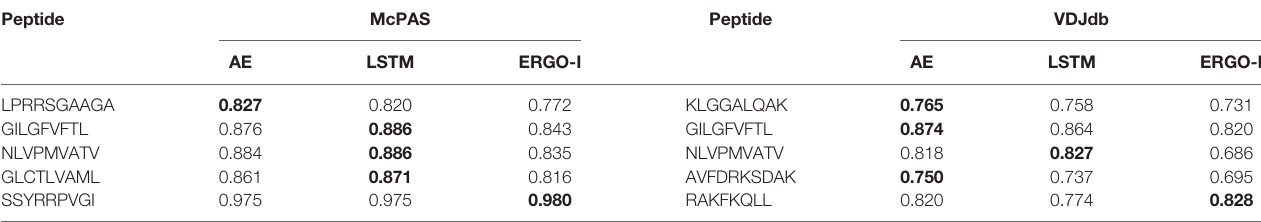
TABLE 2 | Area Under Curve (AUC) of Single Peptide Binding (SPB) prediction task of the fi ve most frequent peptides in McPAS (20) and VDJdb (21) databases. Peptide